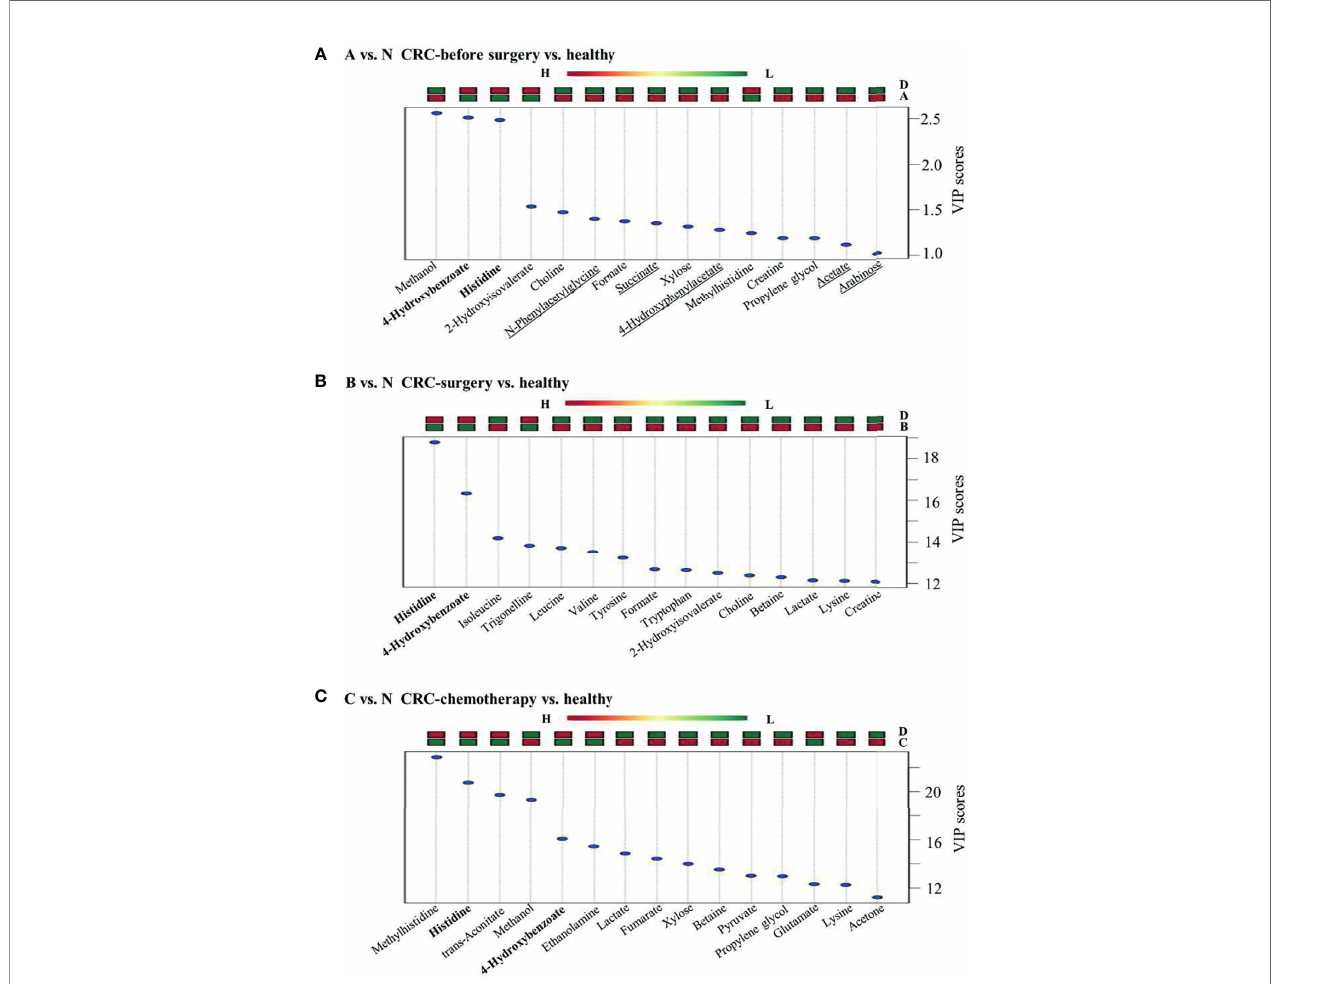
FIGURE 4 | Group comparisons among the three pairs of clinical groups. (A) CRC patients versus healthy controls, (B) CRC surgery versus healthy controls, and (C) CRC chemotherapy versus healthy controls. Metabolites found in all three comparison groups are shown in bold. Metabolites uniquely identi fi ed in panel (A) are underlined. Up or downregulation of each metabolite is presented above the fi gure by using color